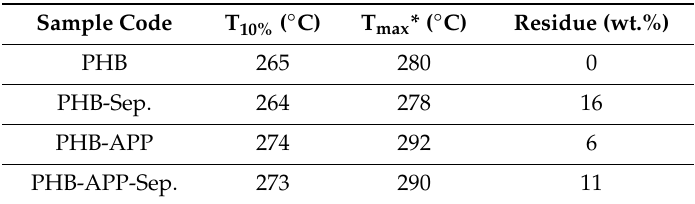
Table 8. TGA parameters PHB and blends in nitrogen (*maximum weight loss temperature, obtained from DTG).